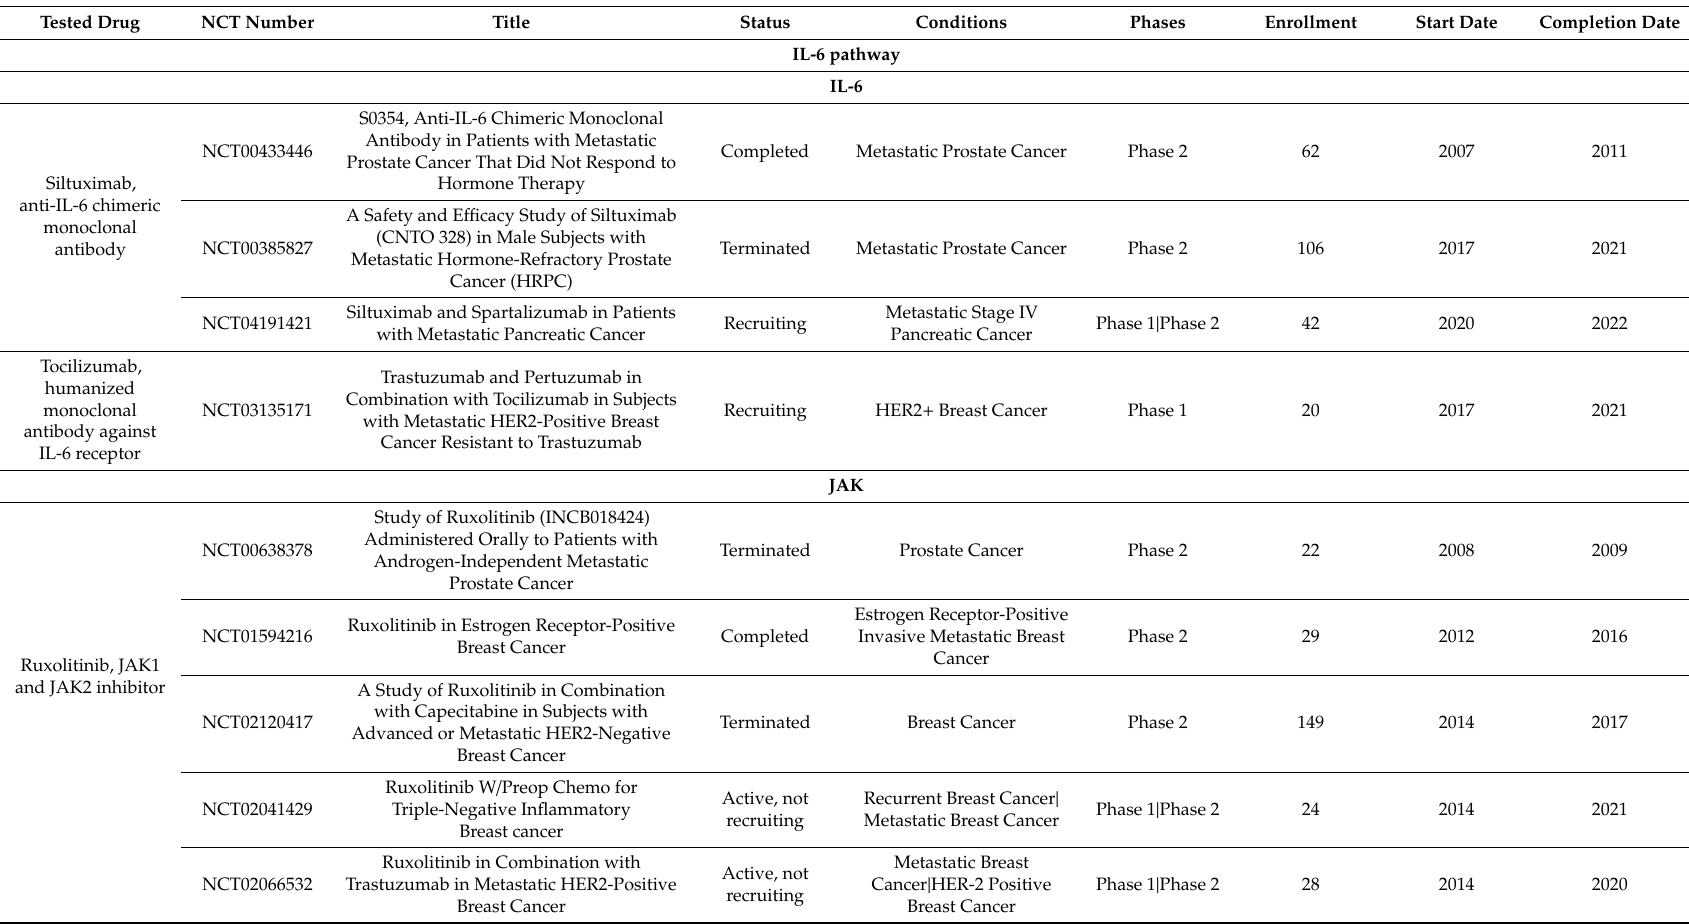
Table 1. Registered clinical trials targeting pro-inflammatory cytokines in patients with cancer